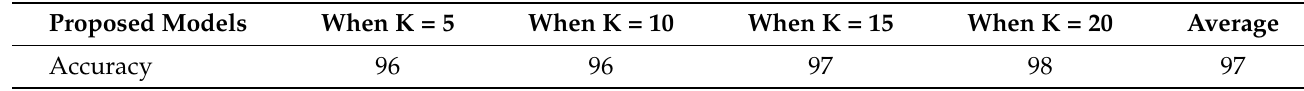
Table 6. Average accuracy after the implementation of soft voting.